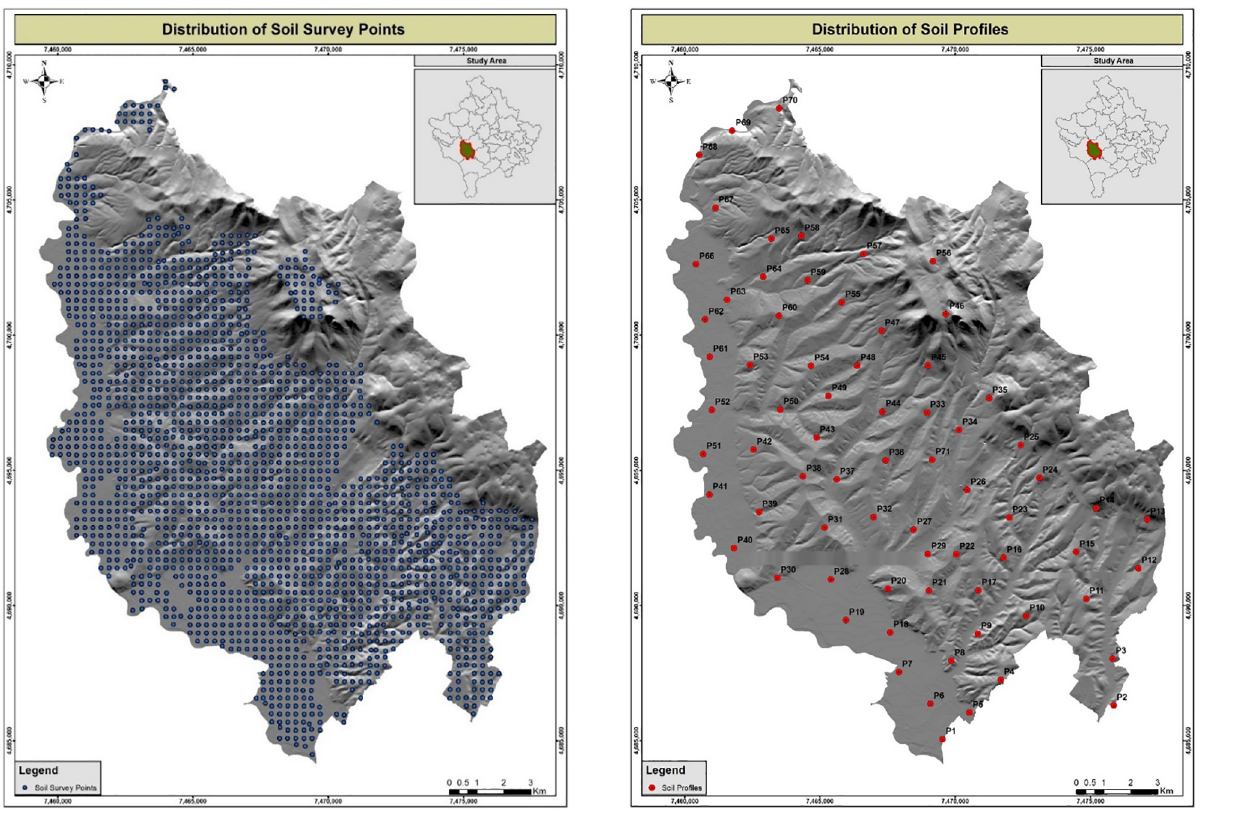
Figure 4. Profiles distribution in the study areaFigure 3. Augers holes distribution in the study